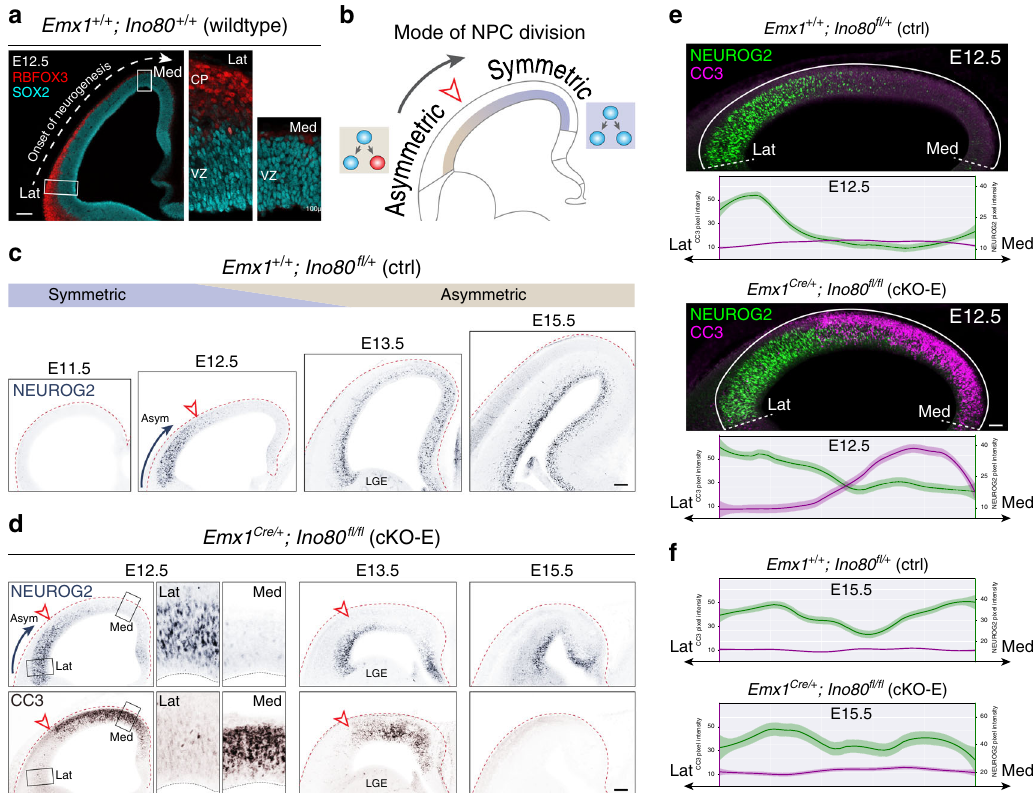
Fig. 6 Spatiotemporal correlation of Ino80 cKO-E apoptosis with mode of NPC division. a At the onset of cortical neurogenesis, the mode of NPC division transitions from symmetric NPC – NPC to asymmetric neurogenic in a lateral – rostral fi rst, medial – caudal last manner along the transverse neurogenetic gradient (TNG). In wild-type E12.5 coronal section, lateral neocortex was characterized by a cortical plate (CP) formed by several rows of RBFOX3 + (red) postmitotic neurons, indicating that the SOX2 + (cyan) NPCs in lateral VZ had transitioned to asymmetric neurogenic divisions. In medial neocortex, the CP was not developed, indicating that medial NPCs had not initiated asymmetric neurogenic divisions ( n = 3 animals). b The progression of the TNG is illustrated in schematic. c Neurogenic NPC marker NEUROG2 immunostaining (blue) of ctrl coronal sections. At E11.5, NPCs were largely NEUROG2- negative and divided symmetrically. At E12.5, NEUROG2 staining was present in lateral, but not medial, NPCs, consistent with progression of the TNG. At E13.5, neurogenesis had progressed more medially, and by E15.5, neurogenic NPCs were present throughout the mediolateral extent of the neocortex ( n = 3 animals). d NEUROG2 (blue) and CC3 (brown) immunostaining of cKO-E coronal sections. In E12.5 and E13.5 cKO-E cortex, lateral NPCs underwent asymmetric (Asym) neurogenic divisions (NEUROG2 + ) and were not apoptotic (CC3 – ), whereas medial NPCs underwent symmetric divisions (NEUROG2 – ) and were robustly apoptotic (CC3 + ). At E15.5, when NPCs had largely transitioned to asymmetric neurogenic divisions (NEUROG2 + ), they no longer underwent apoptosis ( n = 3 animals). e Analysis of immuno fl uorescent pixel intensity from lateral (Lat) to medial (Med) E12.5 cortex revealed complementary gradients of asymmetric neurogenic divisions (NEUROG2, green) and apoptosis (CC3, magenta) in cKO-E (data are LOESS curve ± 99% con fi dence interval, n = 3 animals). f Analysis of immuno fl uorescent pixel intensity revealed asymmetric neurogenic divisions throughout the mediolateral extent of the E15.5 cortex, and no additional apoptosis in cKO-E (data are LOESS curve ± 99% con fi dence interval, n = 3 animals). Scale bar: 100 μ m in a , c , d ; 50 μ m in e